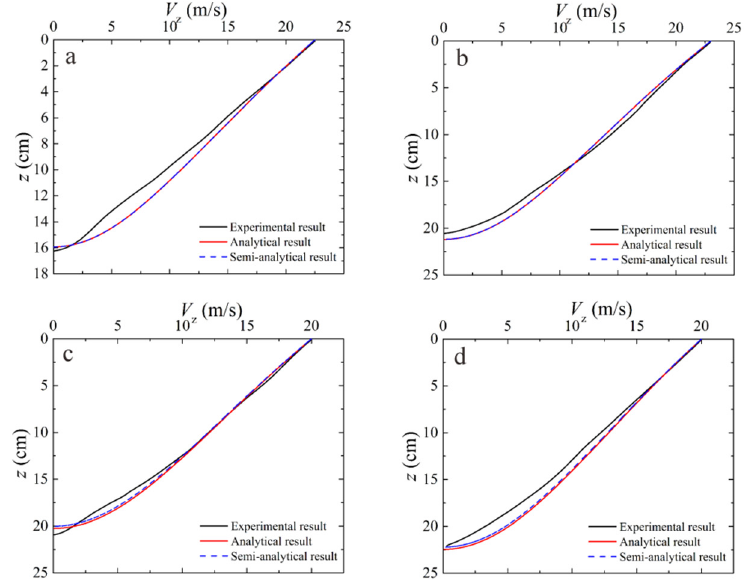
Figure 6. Curves of depth vs. velocity ( a ) D r = 0.80, V 0 = 22.5 m/s; ( b ) D r = 0.70, V 0 = 23 m/s; ( c ) D r = 0.65, V 0 = 20.1 m/s; ( d ) D r = 0.60, V 0 = 20 m/s.